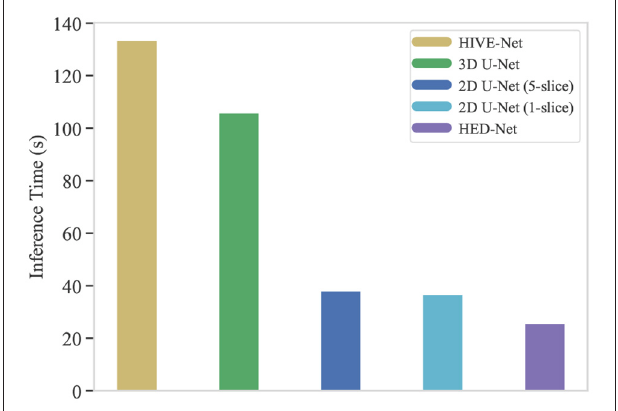
FIGURE 9 | The inference time (in second) of typical segmentation models for 165 images of 768 × 1,024. Our proposed HED-Net takes 25.7 s for inference, while the HIVE-Net takes 133.5 s for